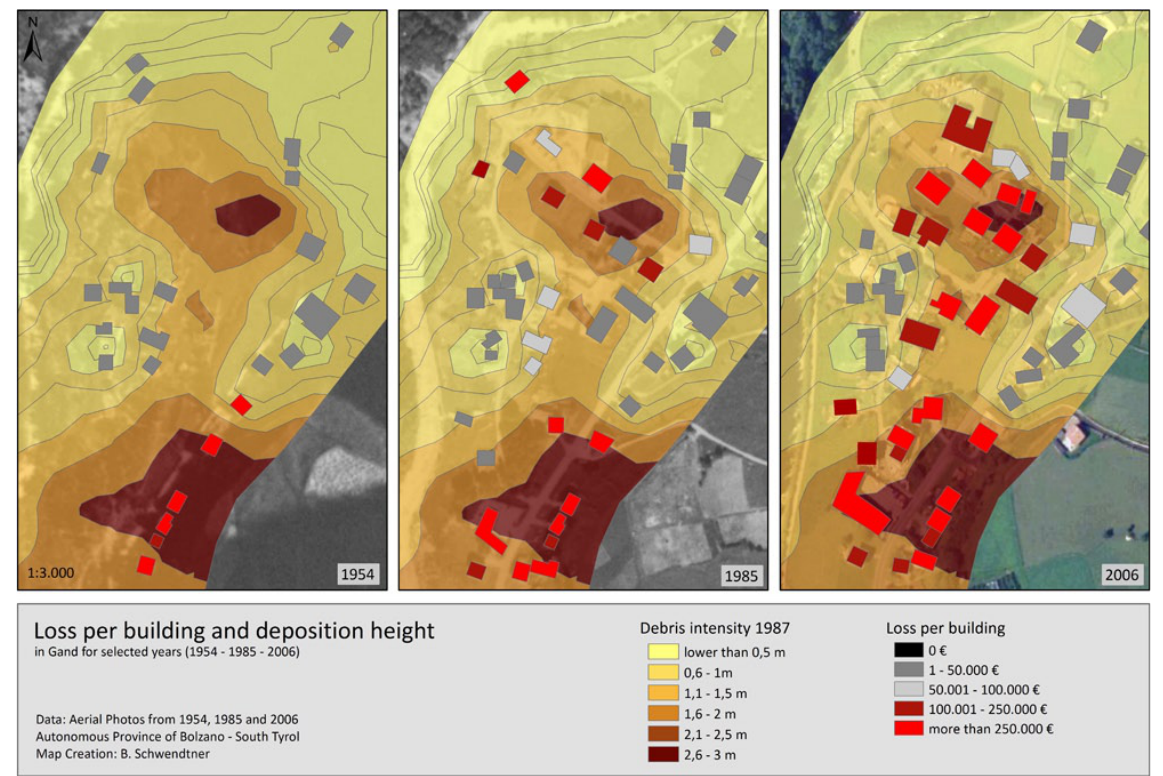
Fig. 7. Visualisation of the damage potential and the deposition height of the 1987